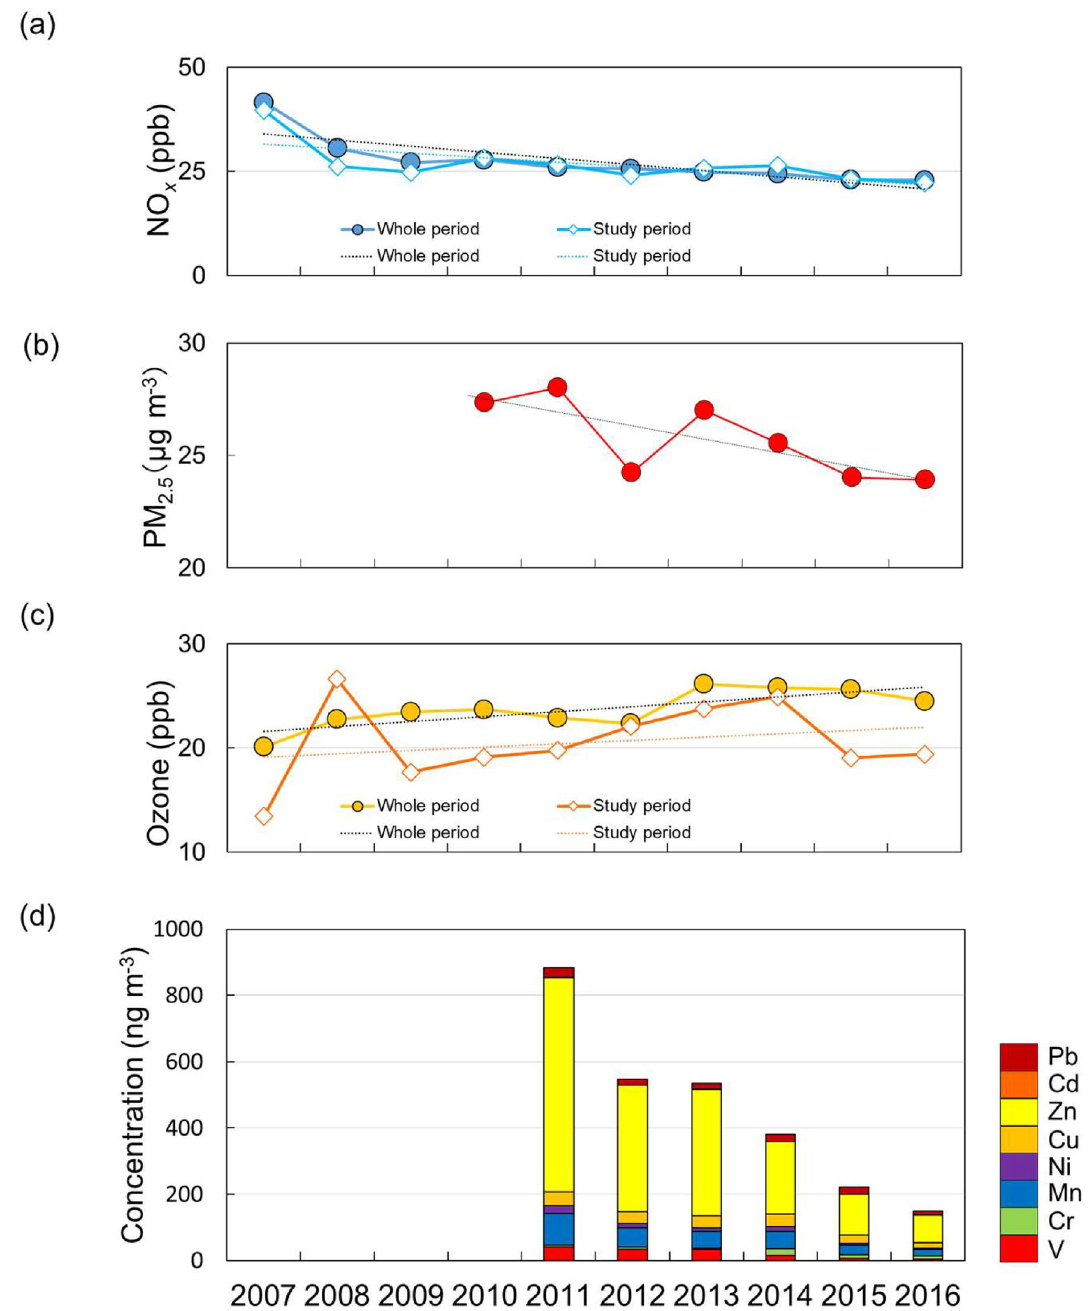
Figure 2. Average annual concentrations of ( a ) NO x during 10 years (y = − 1.48x + 35.6, R = 0.815) and only for the PAHs sampling period (y = − 1.09x + 32.7, R = 0.68), ( b ) PM 2.5 during the PAHs sampling period (y = − 0.61x + 30.0, R = 0.76), ( c ) ozone during 10 years (y = 0.47x + 21.1, R = 0.77) and only for the PAHs sampling period (y = 0.72x + 15.7, R = 0.62 except for 2008) ( d ) anthropogenic elements during the PAHs sampling period, 2007–2016. NO x and ozone data were collected hourly for 10 years and we extracted data for the PAHs sampling period described in Table 1 from the whole data sets. For more details, see “Methods” section in Supplemental